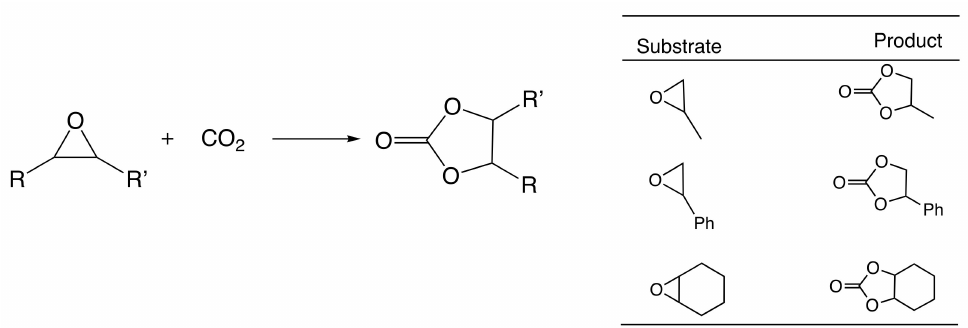
Scheme 1. Selective cycloaddition of CO 2 to